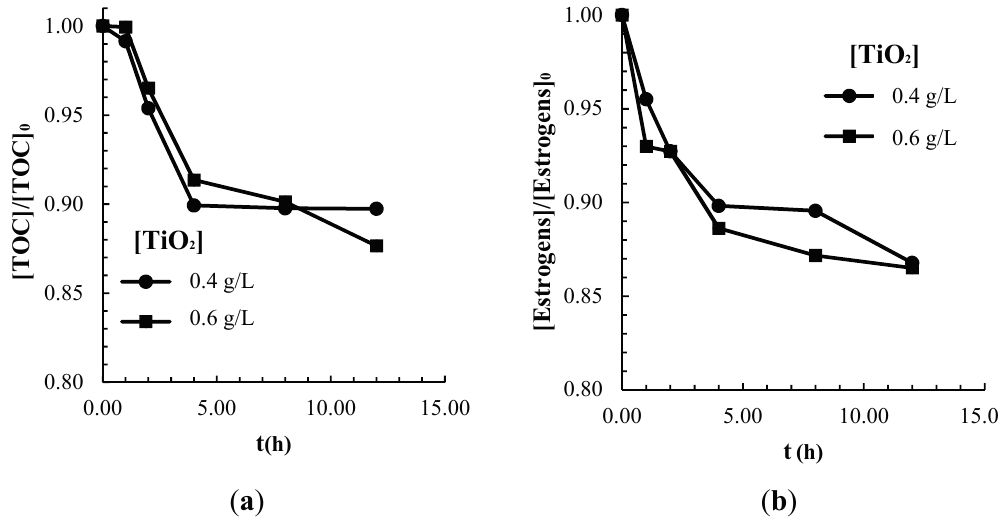
Figure 3. Adsorption of commercial estradiol at 0.4 and 0.6 g/L of catalyst loading with an initial concentration of 7 ppm of estrogens and 429 ppm of TOC: ( a ) TOC removal and ( b ) Estrogens